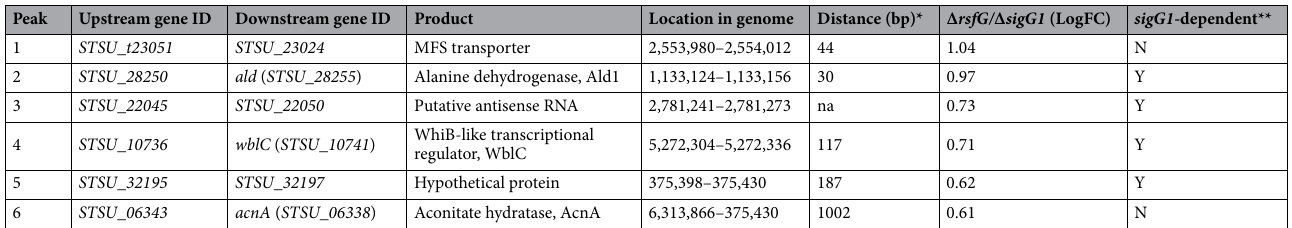
Table 1. SigG1-binding regions identified by ChIP-seq analysis. FC – fold change. *Distance to START codon. **Causal relationship upon sigG1 deletion, RNA-seq.